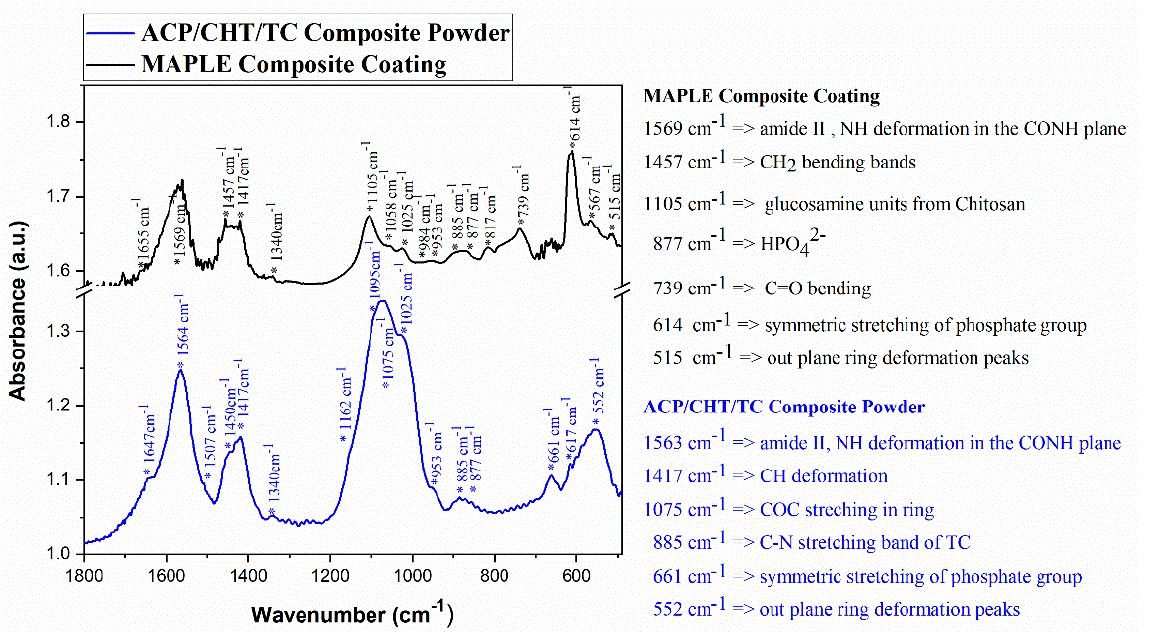
Figure 4. Typical FTIR spectra of composite ACP/CHT/TC powder (blue) and freshly deposited composite film (black). Significant peaks are mentioned.